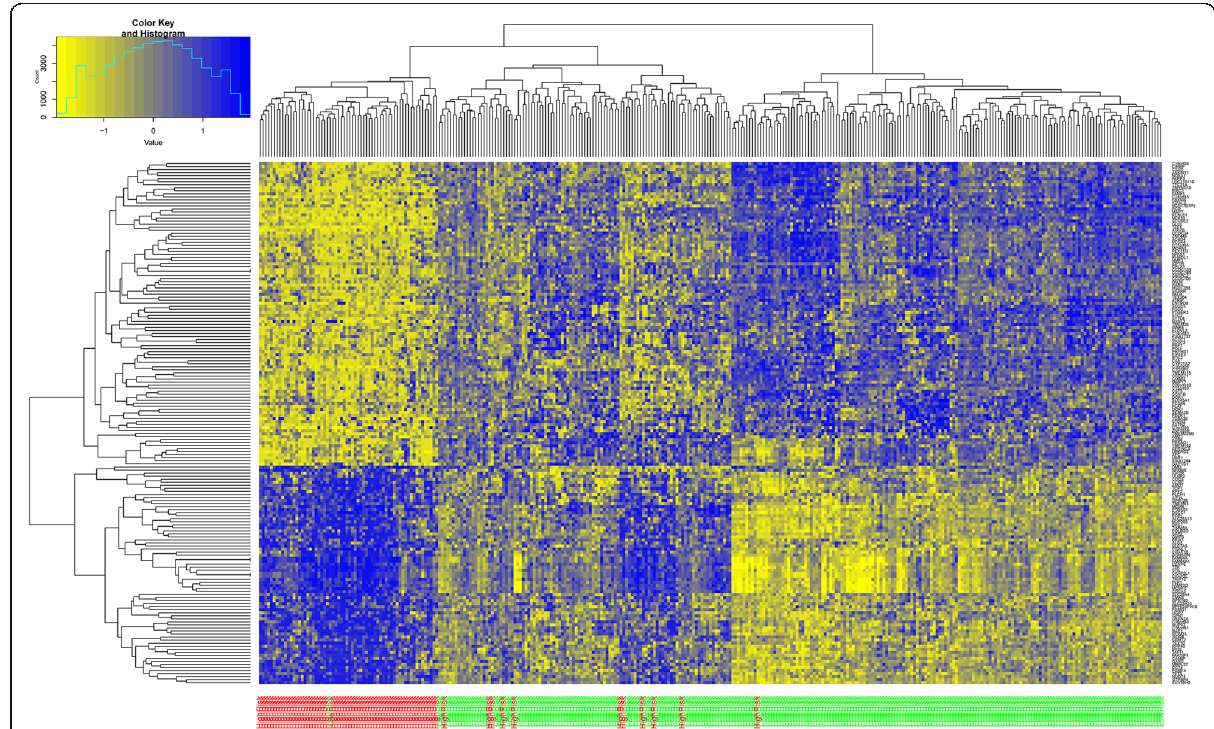
Fig. 3 Supervised hierarchical clustering analysis for coexpressed DEGs. The labels on the abscissa below the plot represent samples, and the markings above the plot represent the clustering of samples. The markings on the longitudinal axis represent the clustering of coexpressed